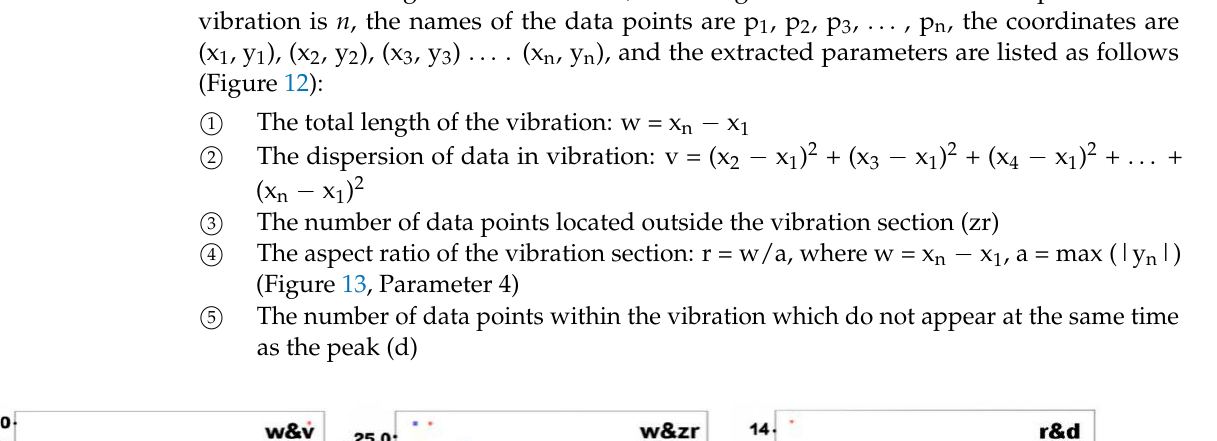
Table 5. Performance of selected parameters in different data sets. Parameter